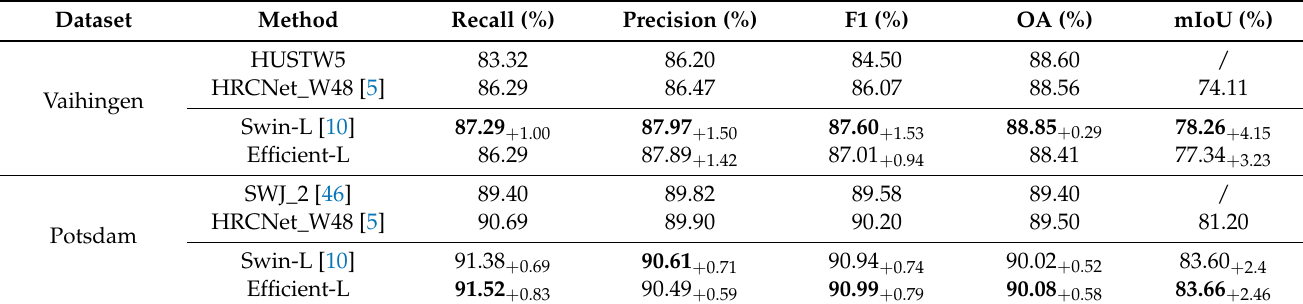
Table 12. Comparison to Top 1 methods on the Vaihingen and Potsdam datasets.